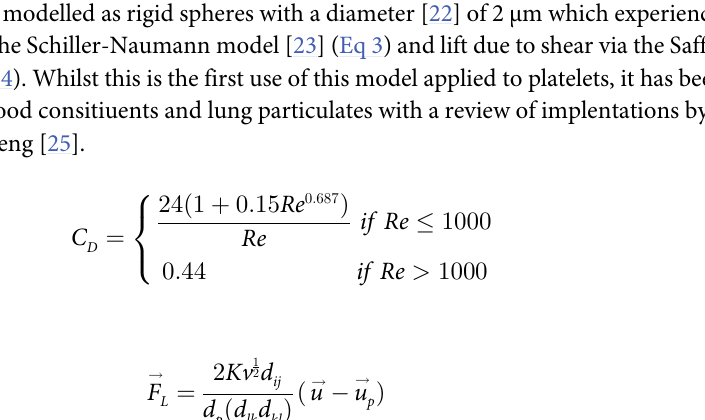
is the diameter of the platelet, u ! is the velocity of the fluid and p